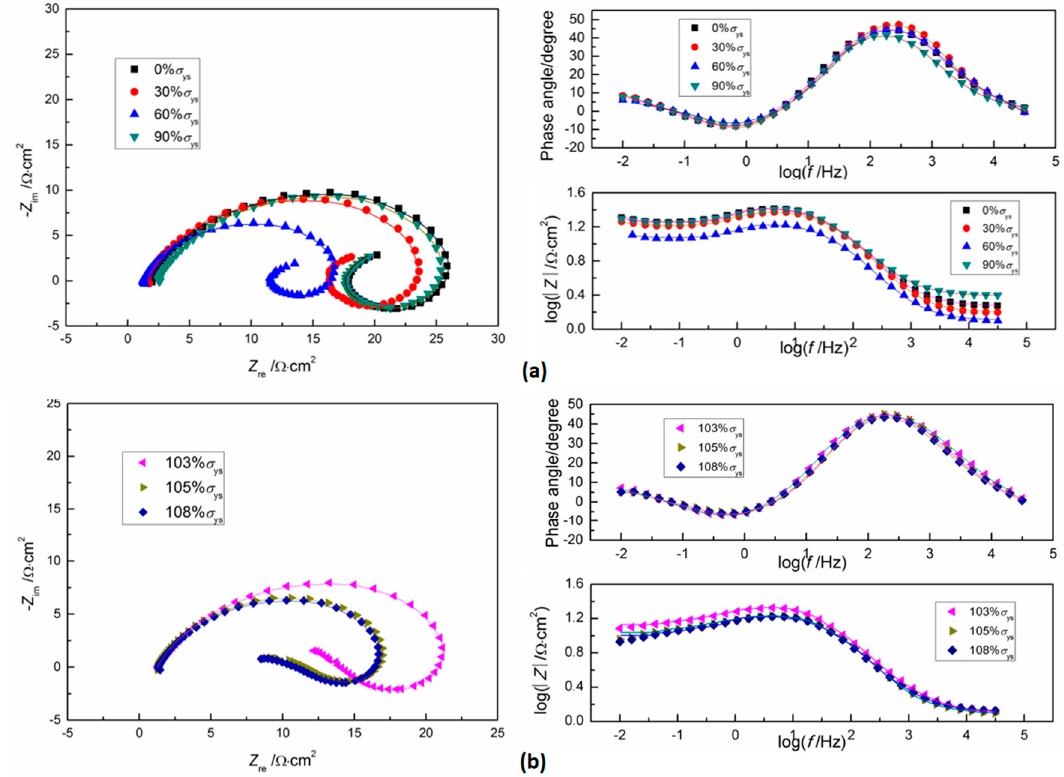
Figure 7. Electrochemical impedance spectroscopy (EIS) curves of X80 steel measured at +60 mV (vs. open-circuit potential, OCP) in 3.5 wt% NaCl aqueous solution with saturated CO 2 under different ( a ) elastic and ( b ) plastic tensile stress at 30 °C. Symbol: Experimental data; and line: Simulation data.